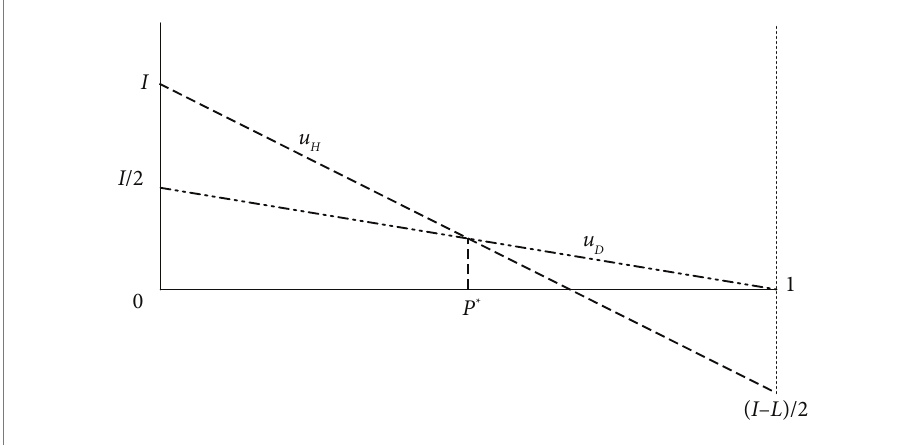
Fig. 1. The evolutionarily stable